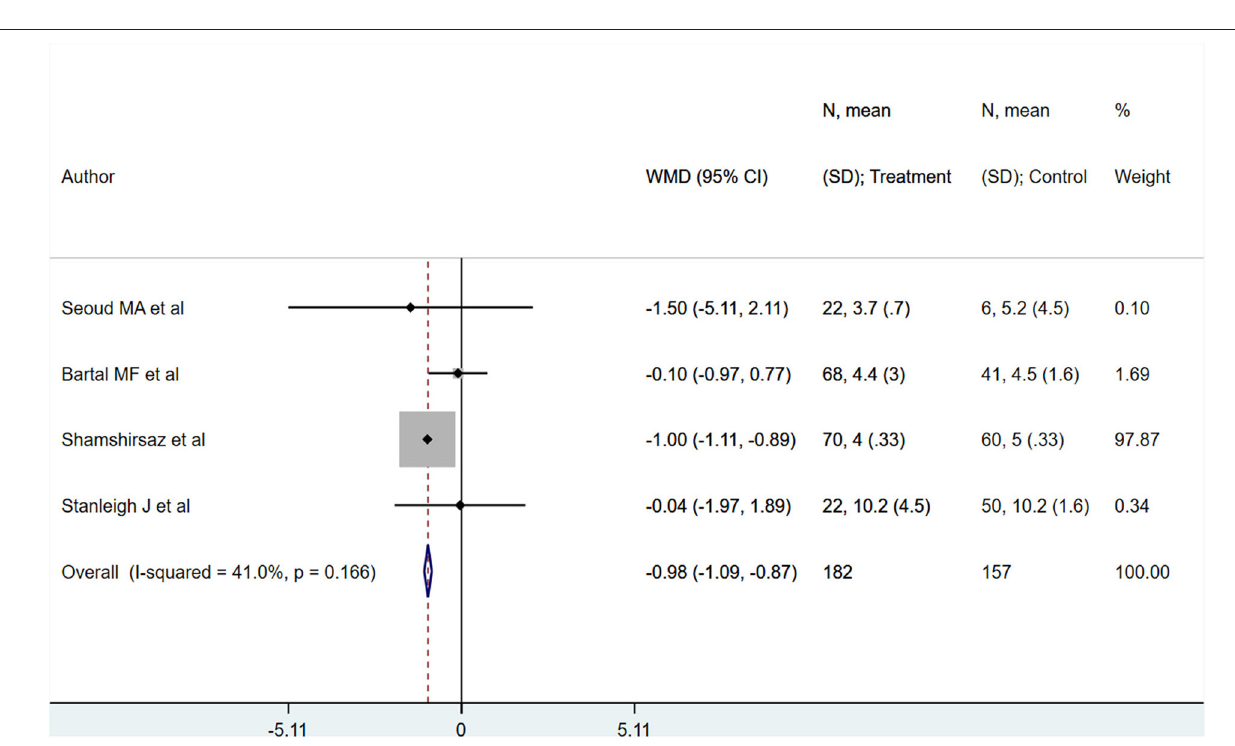
Frontiers in Medicine |